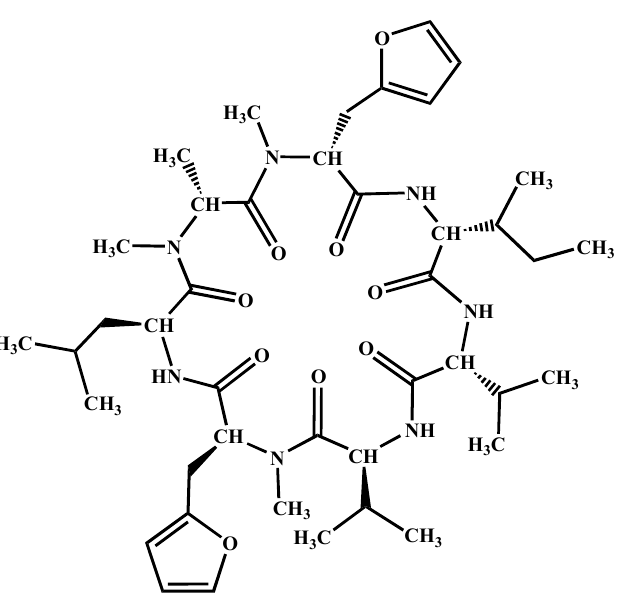
Figure 4. Structure of compound 1 .